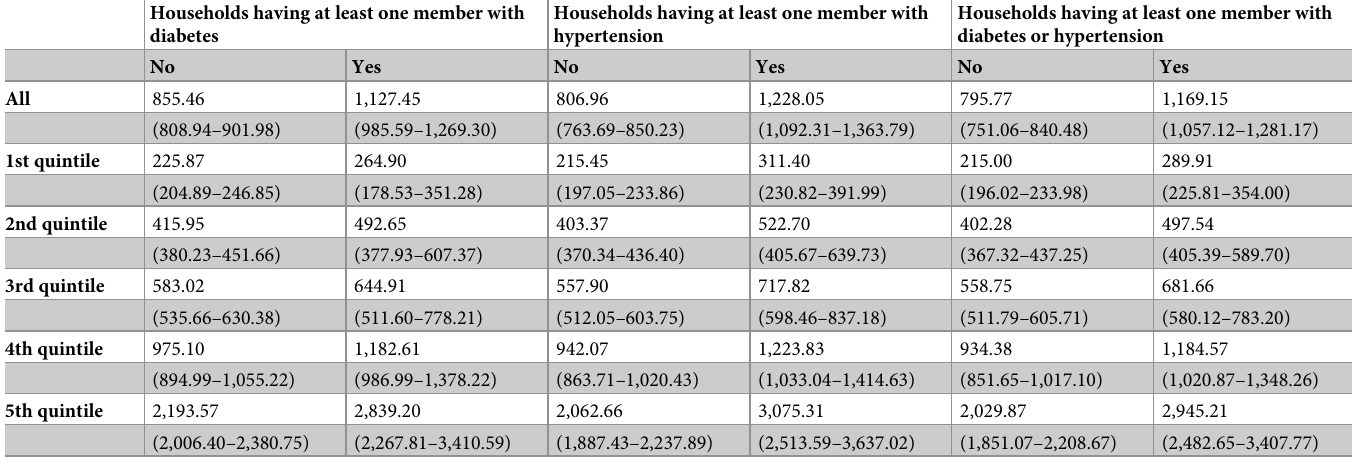
Table 1. Average (95% confidence intervals) household quarterly health expenditures (in pesos) among Mexican households according to presence of household members with diagnosed diabetes or hypertension.